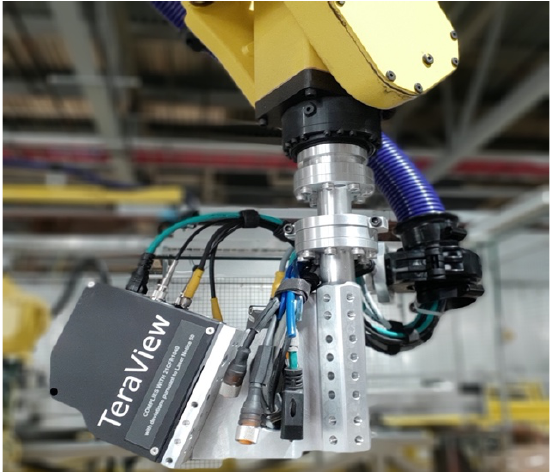
Figure 5. TeraView’s TeraCota sensor at the end of automotive grade robot installed at a production plant in the United States of America.